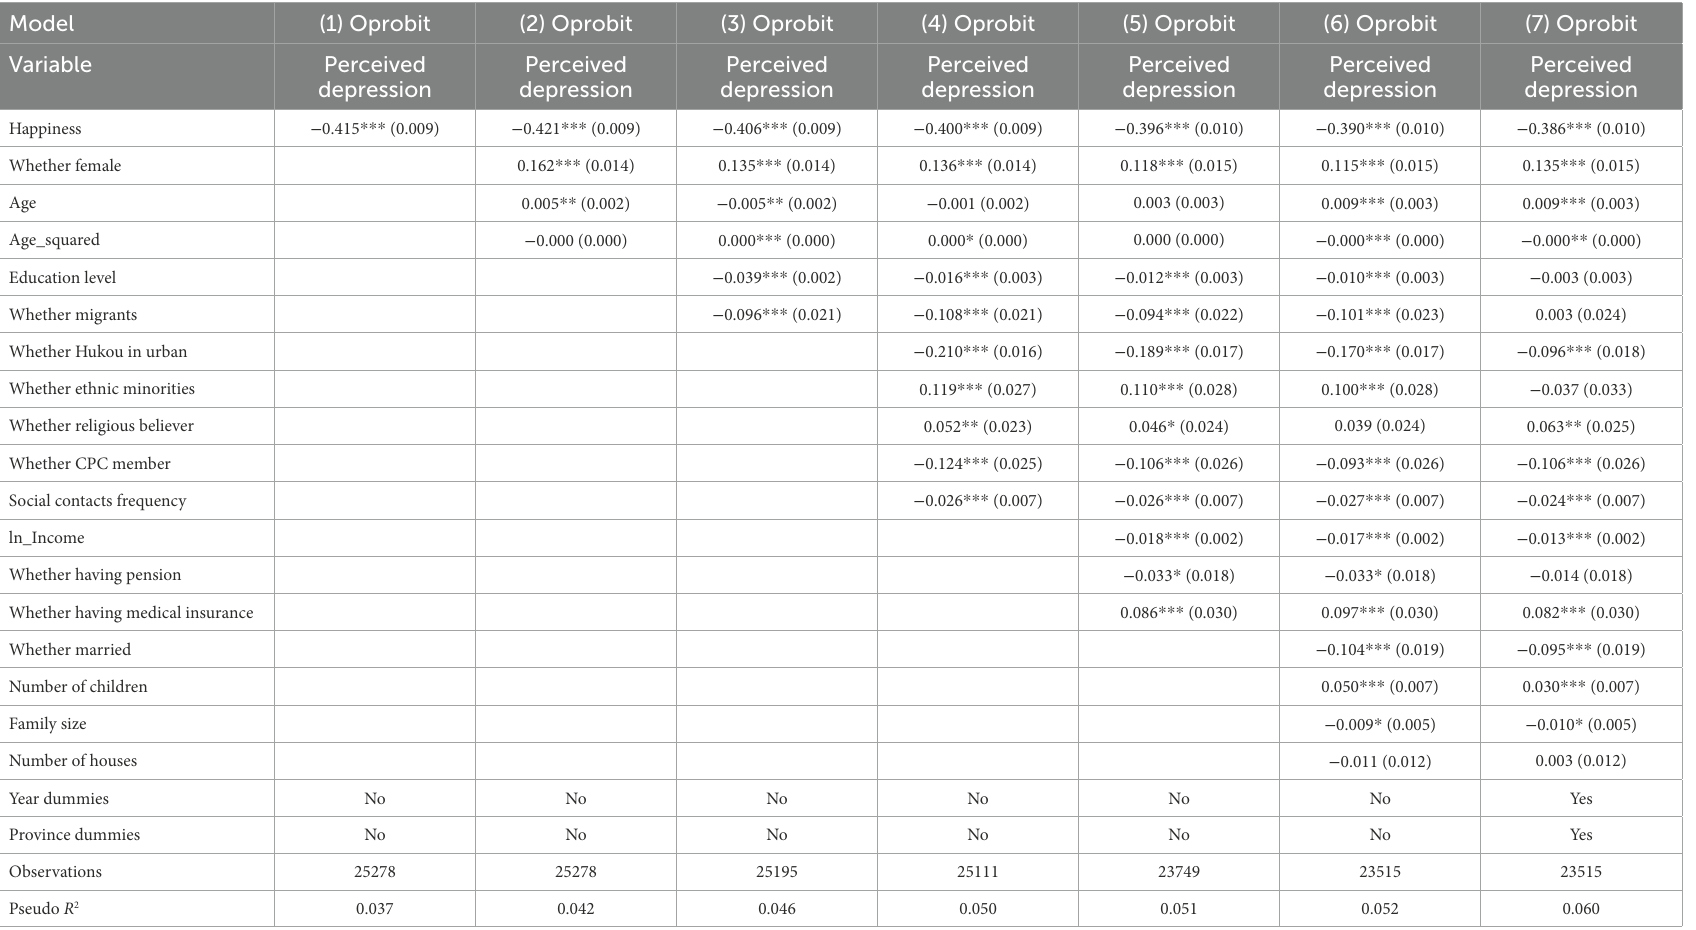
TABLE 1 Relationship between subjective well-being and perceived depressive disorders.